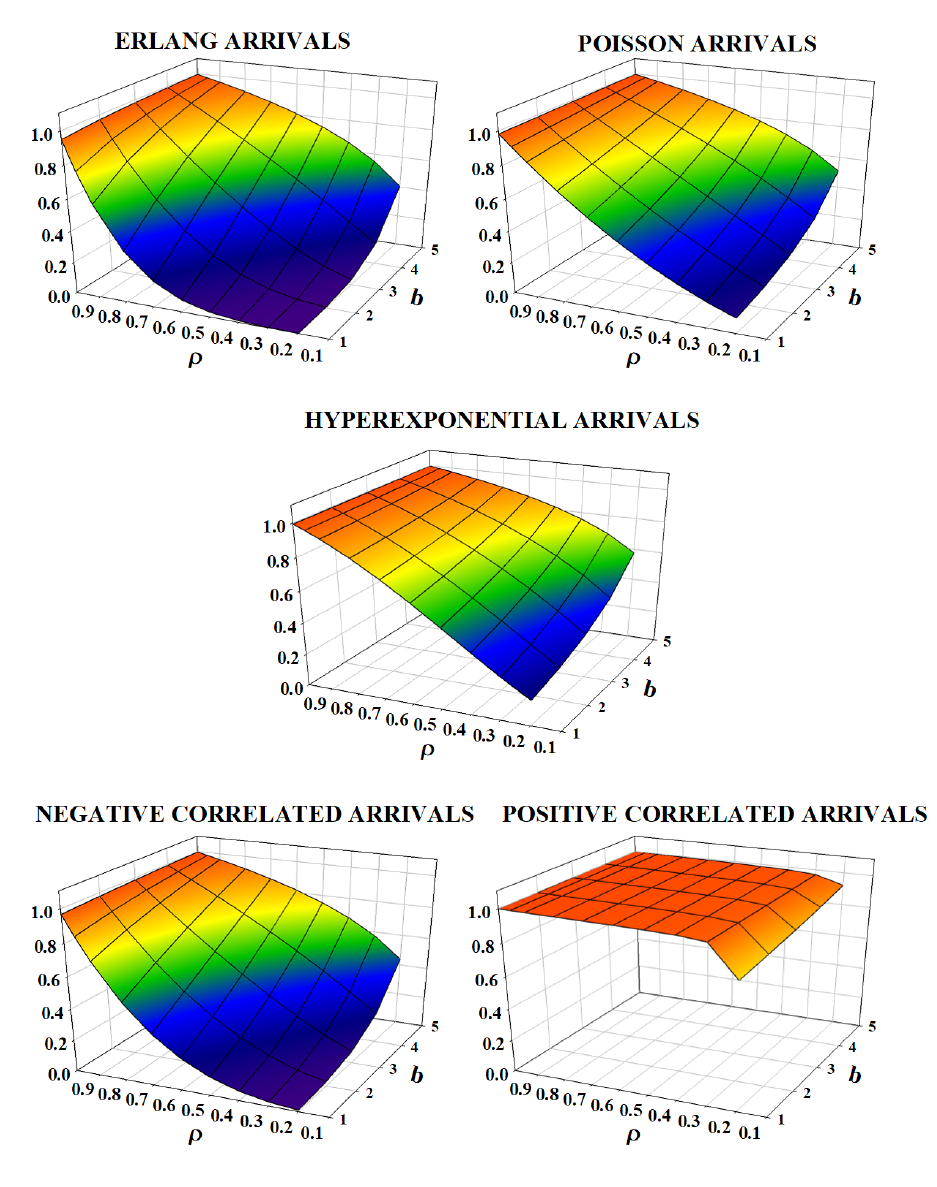
Figure 5. Spectral radius ( η ) of the matrix R for example